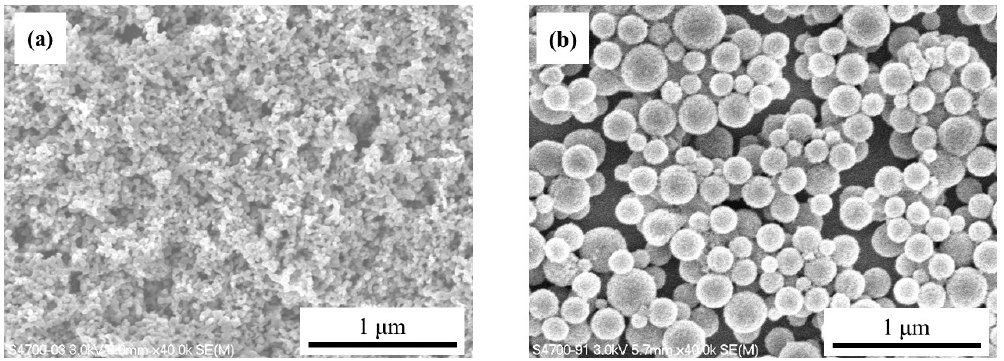
Figure 4. Top-view SEM images: ( a ) P25 and ( b ) NSA.